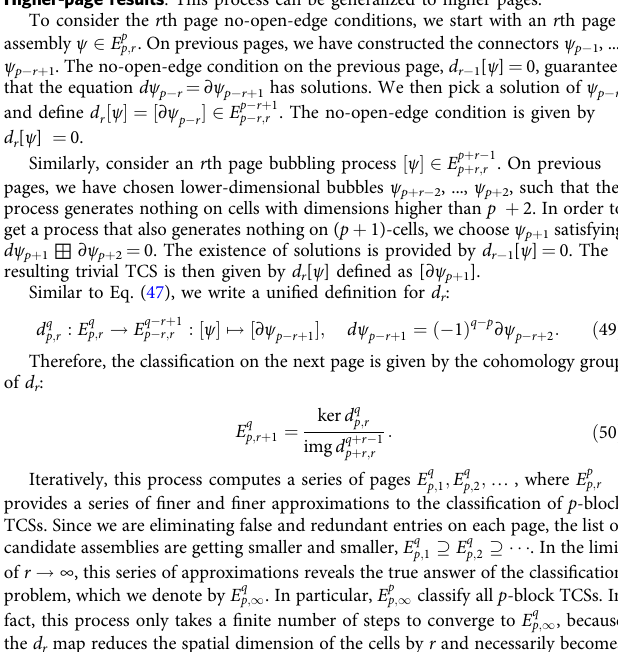
generators for 2